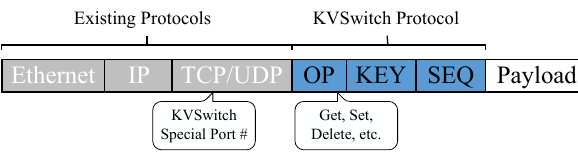
Figure 2. Network protocol of